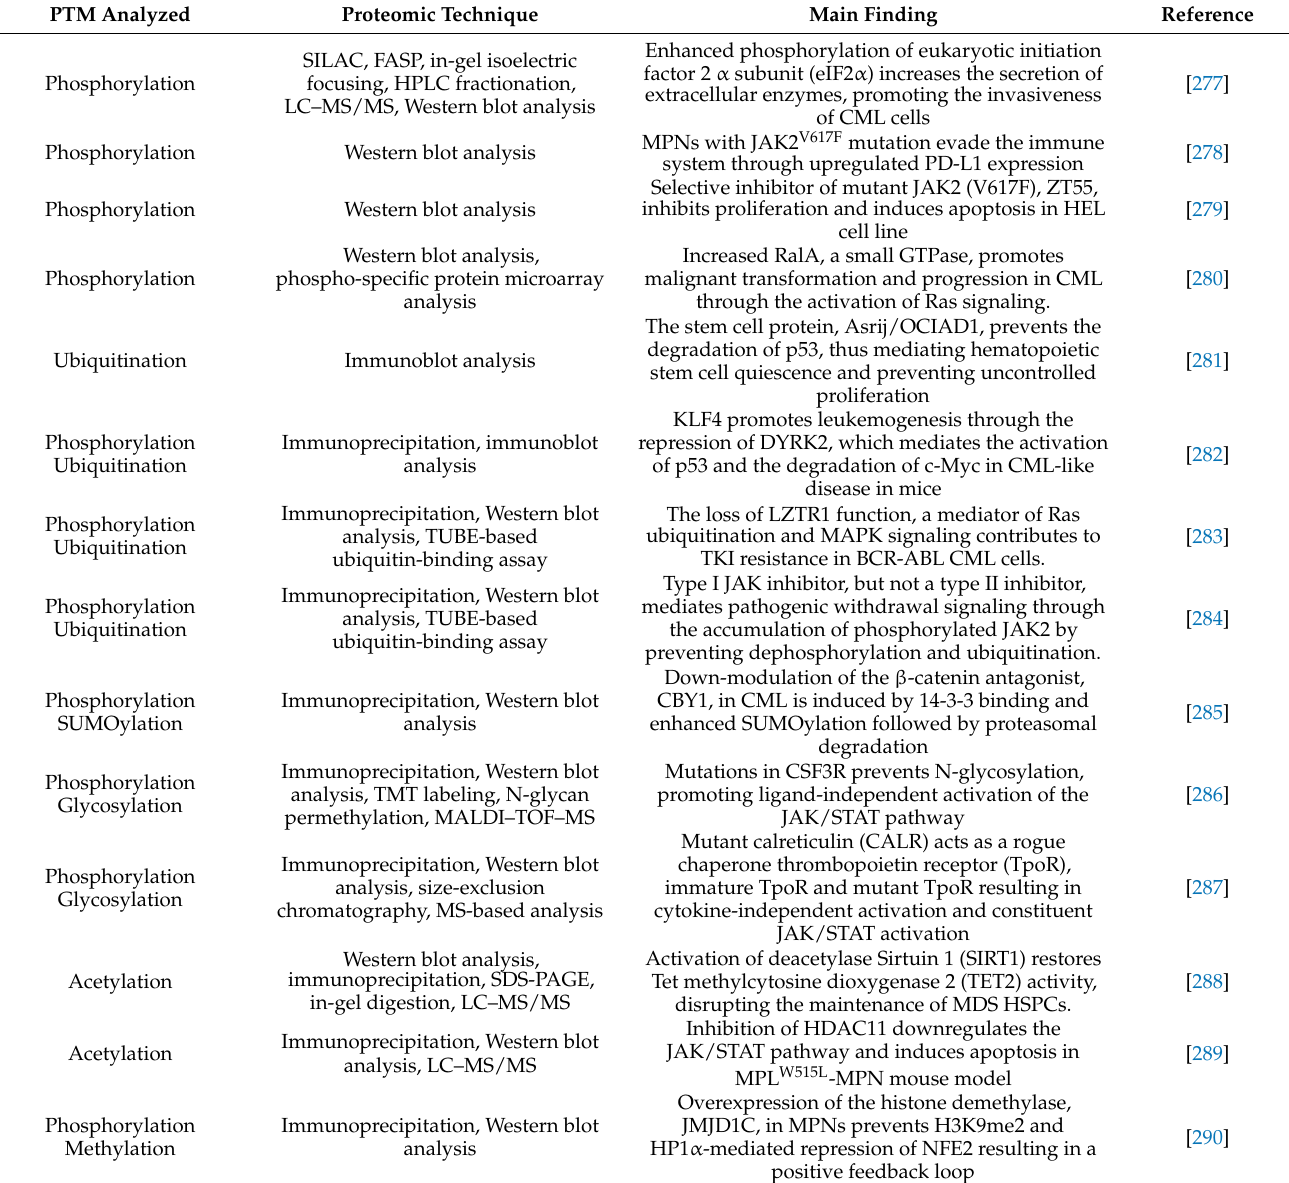
Table 4. Recent studies utilizing proteomic techniques to analyze PTMs in myeloproliferative neoplasms. PTM